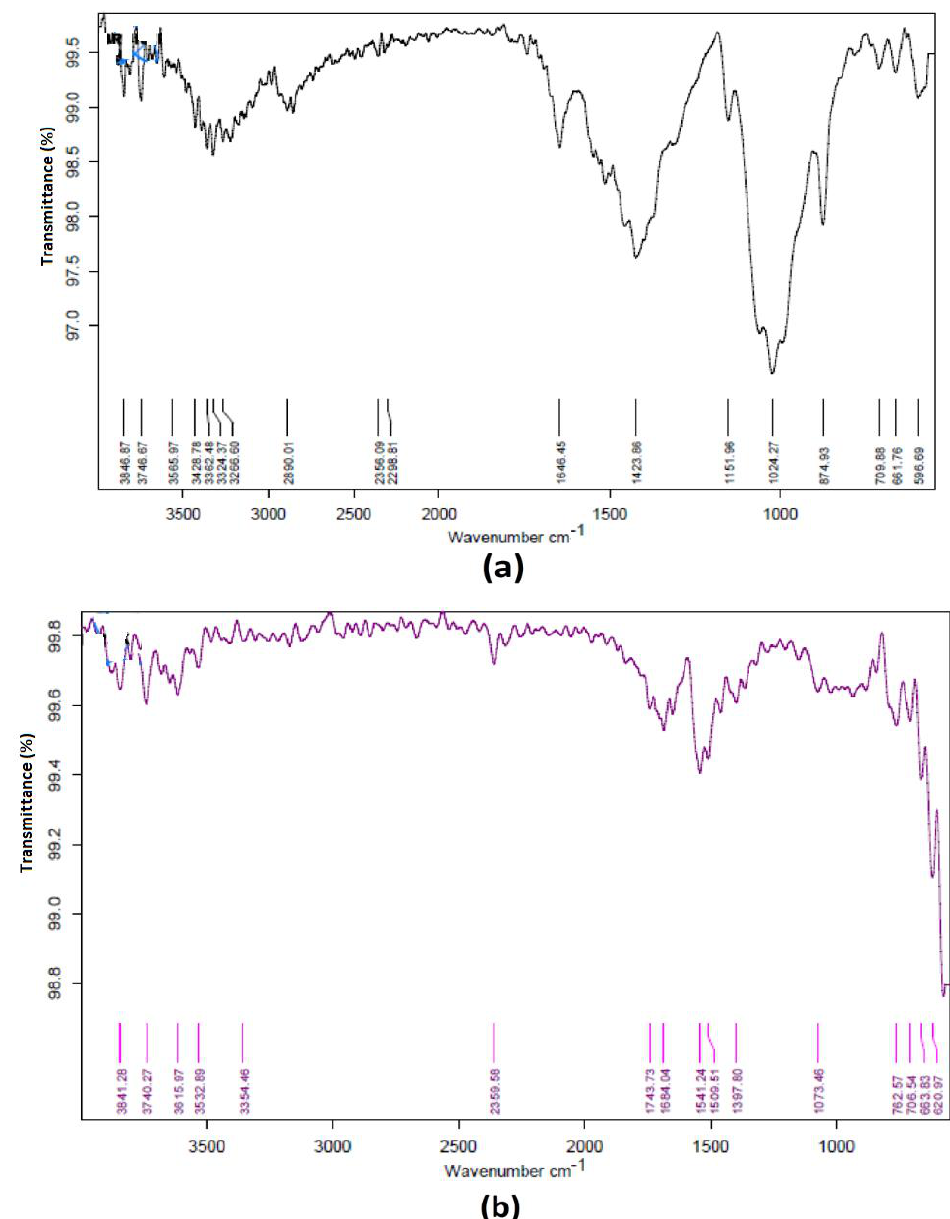
Figure 2. FTIR spectra of ( a ) parent chitosan and ( b )